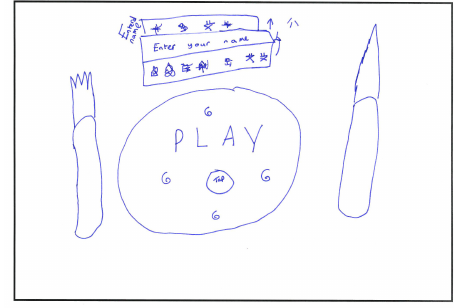
Figure 3. Example of an introduction screen